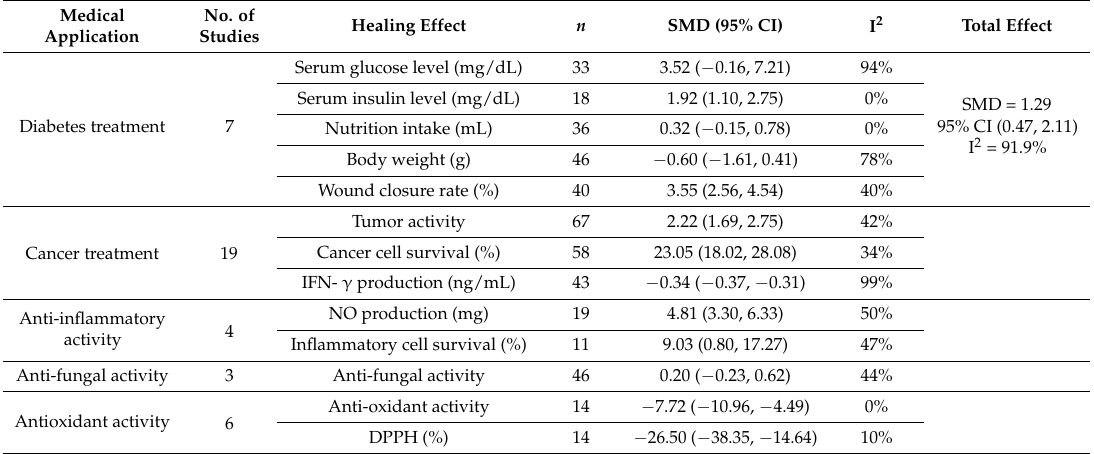
Figure 5. Comparison of levels of tumor activity between control and S. crispa groups. ( ): SMD of individual studies; ( ): summary SMDs of the comparison. Figure 10. Comparison of oxidative inhibitory capacity between control and S. crispa groups. ( ): SMD of individual studies; ( ): summary SMDs of the comparison.